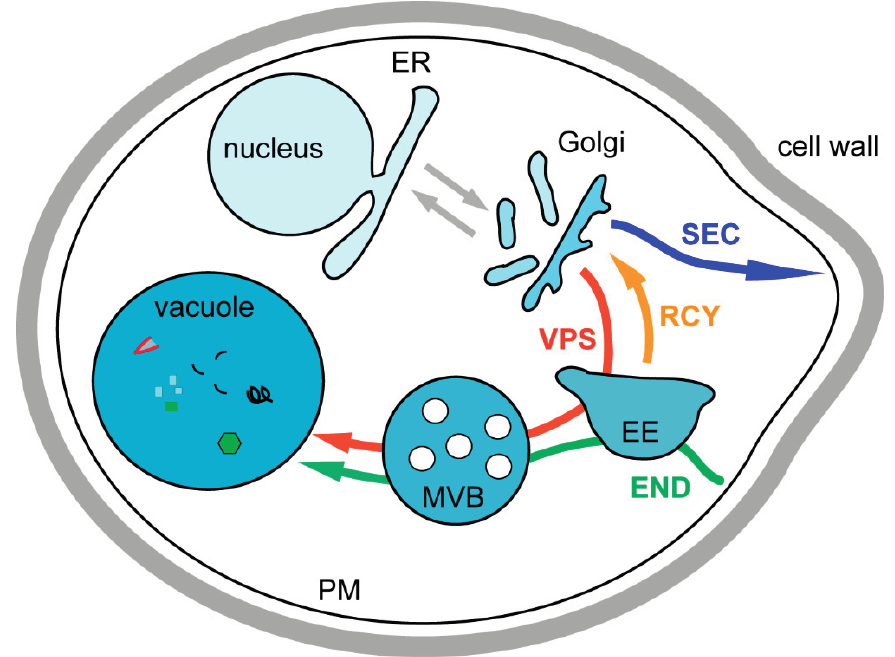
Figure 2. Representation of the different yeast intracellular trafficking pathways. Organellar soluble and membrane proteins are synthesized at the endoplasmic reticulum (ER) and transported to the unstacked Golgi (grey arrow). At the Golgi, these proteins are sorted into anterograde transport vesicles for ER resident proteins (grey arrow), into secretory (SEC) vesicles for plasma membrane (PM) and extracellular proteins (blue arrow), and into vacuolar protein sorting (VPS) vesicles for vacuolar proteins passing through endosomes (red arrow). The endocytic pathway (END) is used for internalization of PM proteins and extracellular medium components (green arrow). At the early endosomes (EE), proteins are sorted between those targeted for degradation into the vacuole, after maturation of the EE into the late endosome or multivesicular body (MVB), and those that are following the recycling pathway (RCY) to avoid degradation by being targeted to the Golgi (orange